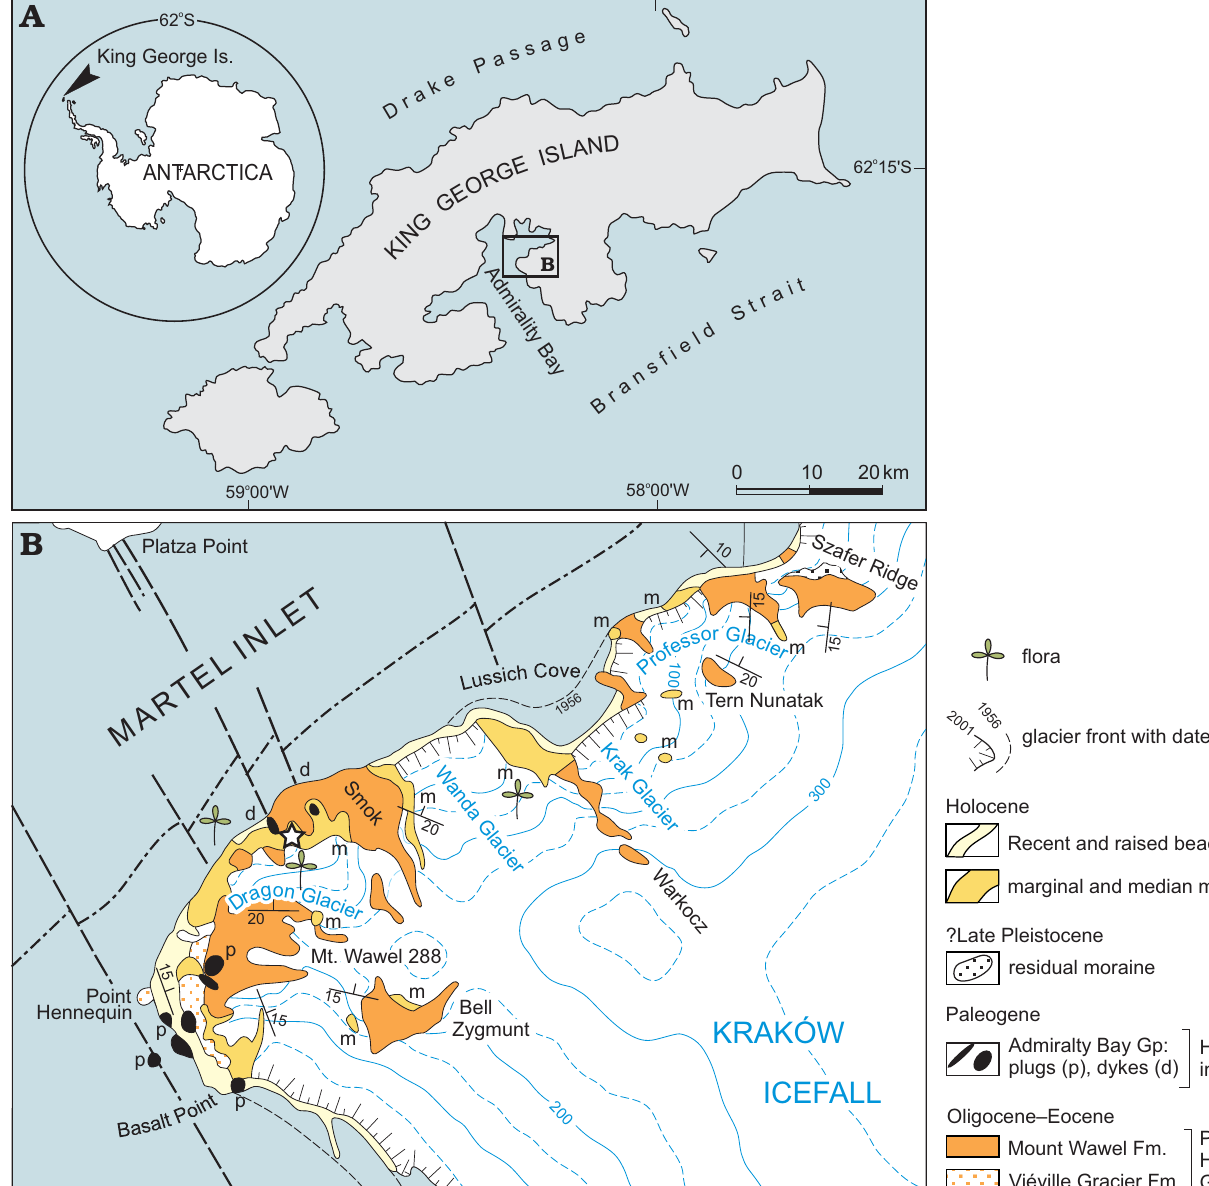
Fig. 1. Map of King George Island ( A ) and location of the study region ( B ), after Birkenmajer (2002) with locality indicated